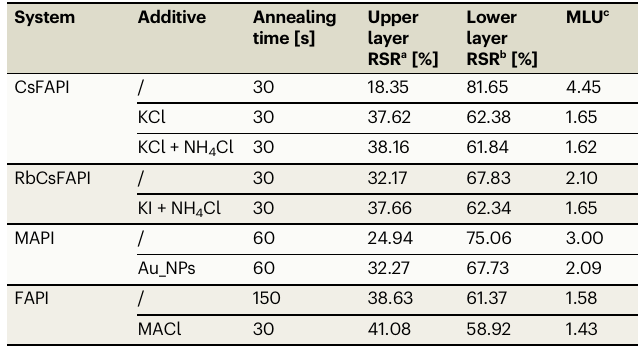
Table 3 | Analysis of the residual solvent System